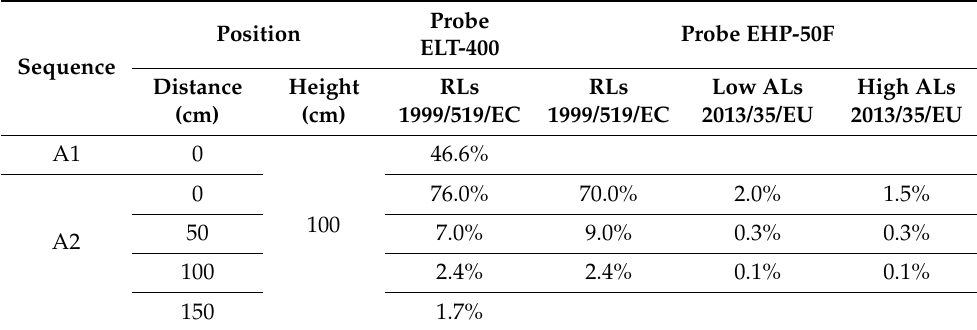
Table 5. Measurement results with ELT-400 probe (postprocessing of data acquired from the analogue